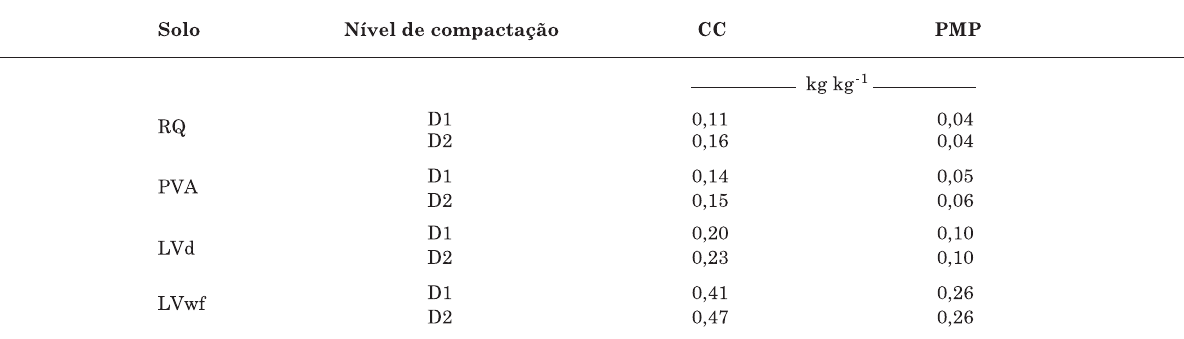
RQ: Neossolo Quartzarênico; PVA: Argissolo Vermelho-Amarelo; LVd: Latossolo Vermelho distrófico; LVwf: Latossolo Verme- lho acriférrico; D1: menor densidade do solo; D2: maior densidade do solo; CC: capacidade de campo a -0,006 MPa e PMP: ponto de murcha permanente a -1,5 MPa.